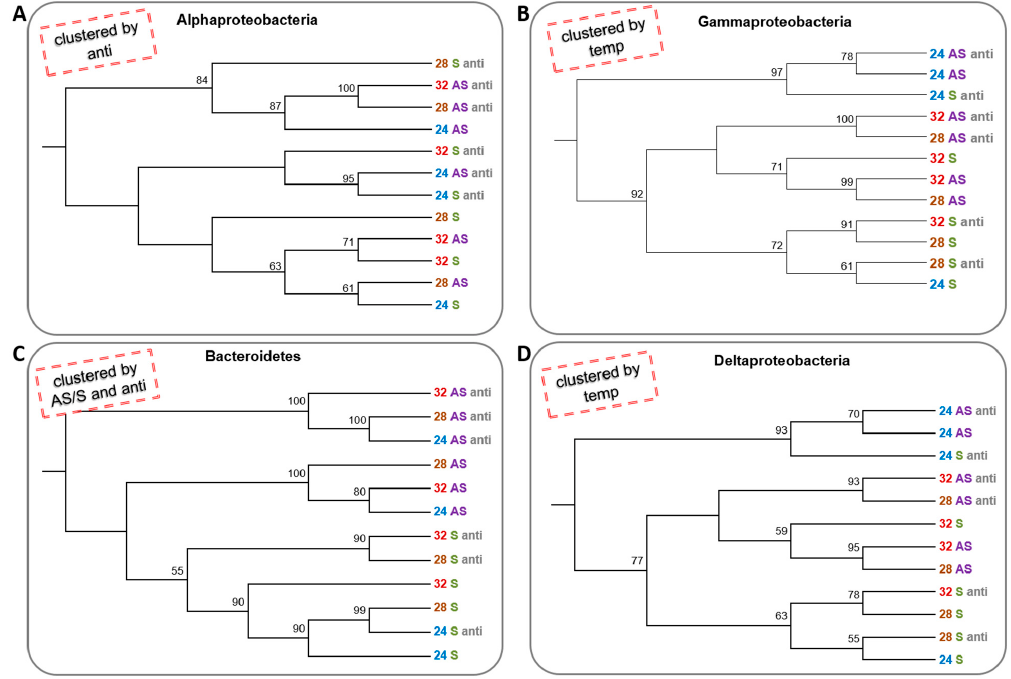
Figure 4. Cluster analysis of microbial community from four bacterial groups of 16S rRNA NGS libraries generated from E. paradivisa samples. ( A ) Alphaproteobacteria ( B ) Gammaproteobacteria ( C ) Bacteroidetes and ( D ) Deltaproteobacteria. An unrooted neighbour-joining tree of communities by 16S rRNA gene NGS. Bootstrap values represent 100 iterations. Retrieved sequences were analysed using MOTHUR software [40]. The headlines (in the red dashed box) indicate the main factor or factors that affect the clustering pattern. Labels are coloured according to the temperature treatment and the symbiotic